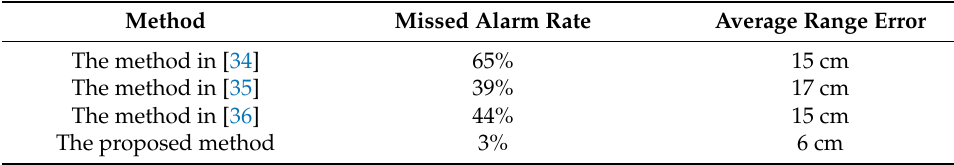
Table 3. Results of 50 sample data processed by different methods.